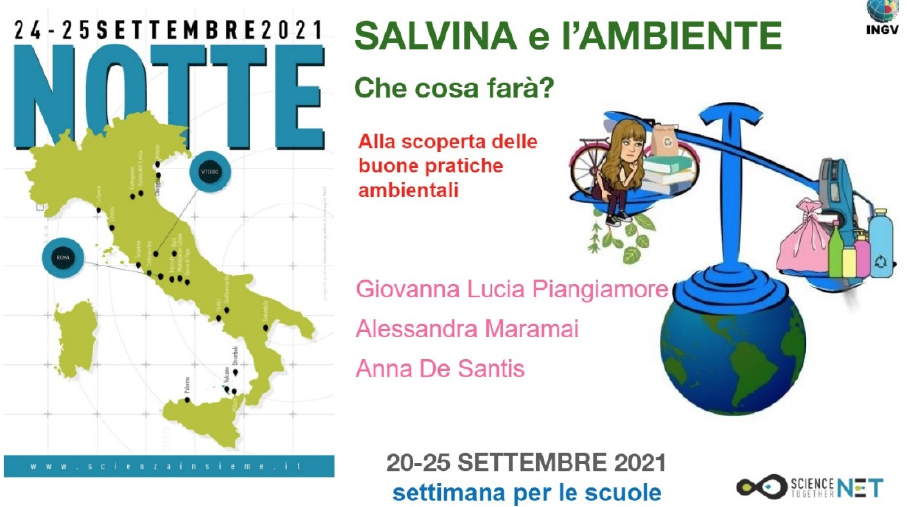
Figure 5. Poster of the Salvina and the environment , discovering the eco-friendly behaviors, played online at the European Researchers’ Night 2021 .